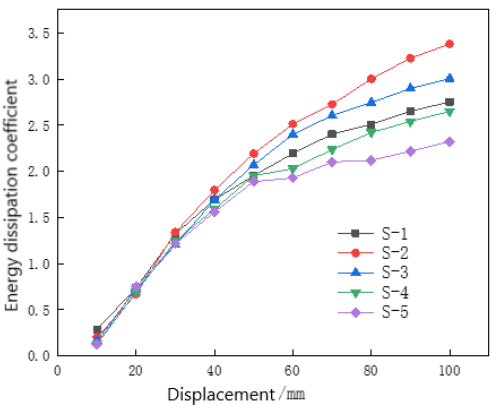
Figure 13. Energy dissipation coefficient of S Series joints with